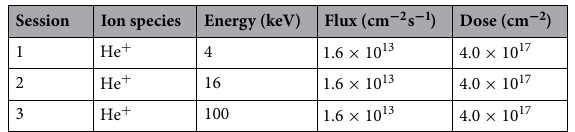
Table 1. Summary of the irradiation parameters considered and used in the tests.